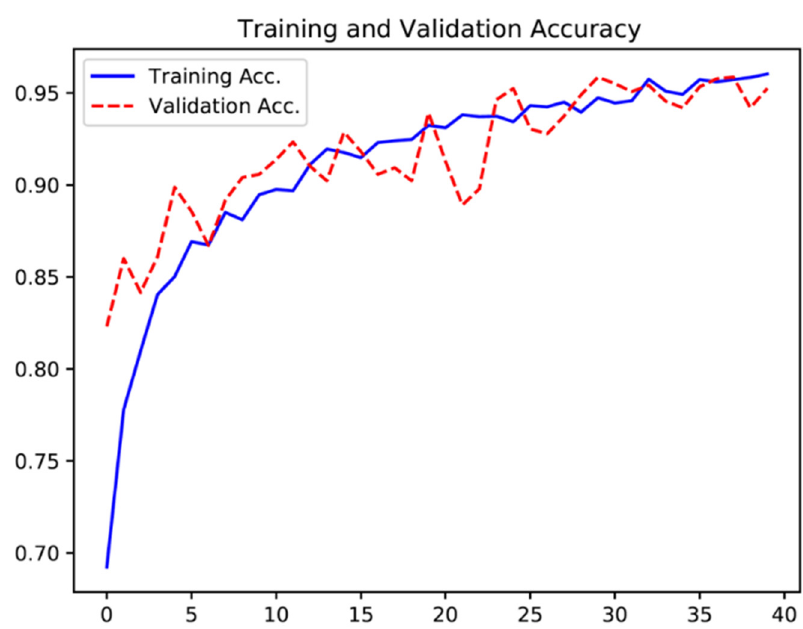
Figure 3. Evolution of the accuracy of the convolutional neural network during training and valida- tion phases, as the training and validation datasets were repeatedly inputted in the neural network. Table 1. Confusion matrix and performance